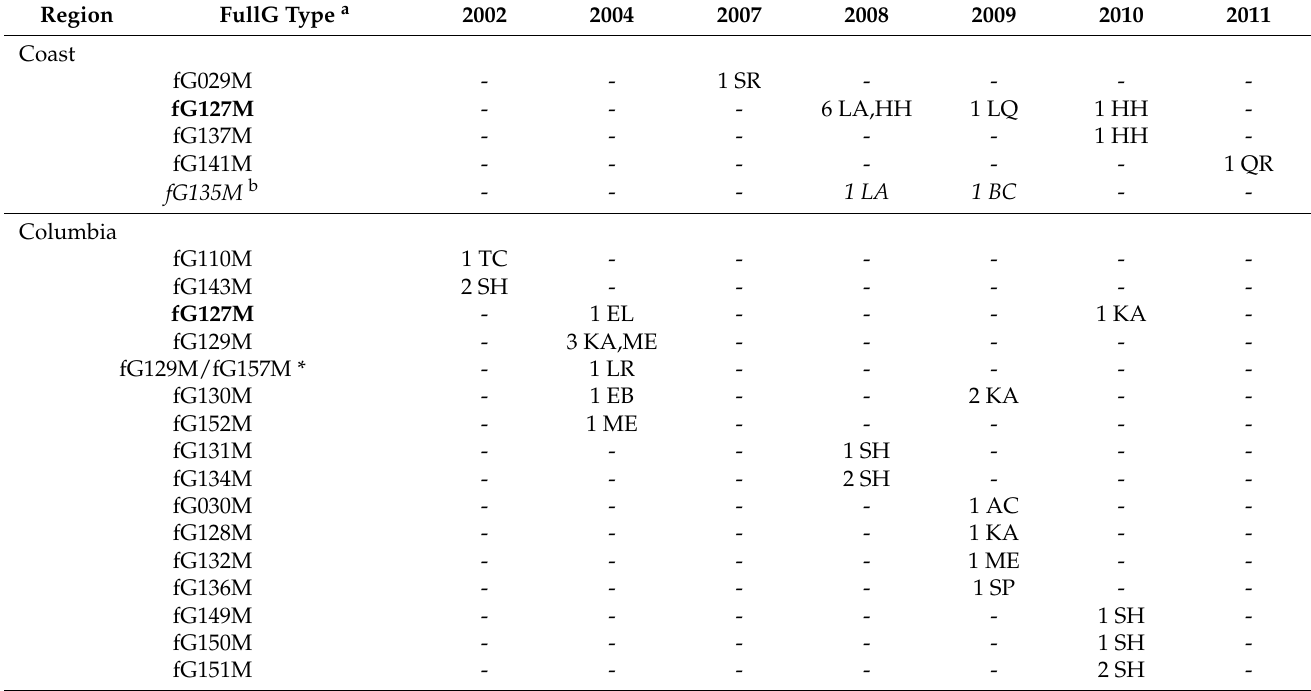
Table 2. Full G genotypes identified in mG110M IHNV isolates from the second MD IHNV emergence event in coastal steelhead. Regional and temporal distribution are shown for mG110M isolates in the coast region during the period 2007–2011 and for candidate source isolates from the Columbia region in preceding and concurrent years. Numbers in columns are numbers of isolates, with locations indicated as shown in Figure 1. Dashes indicate no detection of a given fG genotype in a given year.